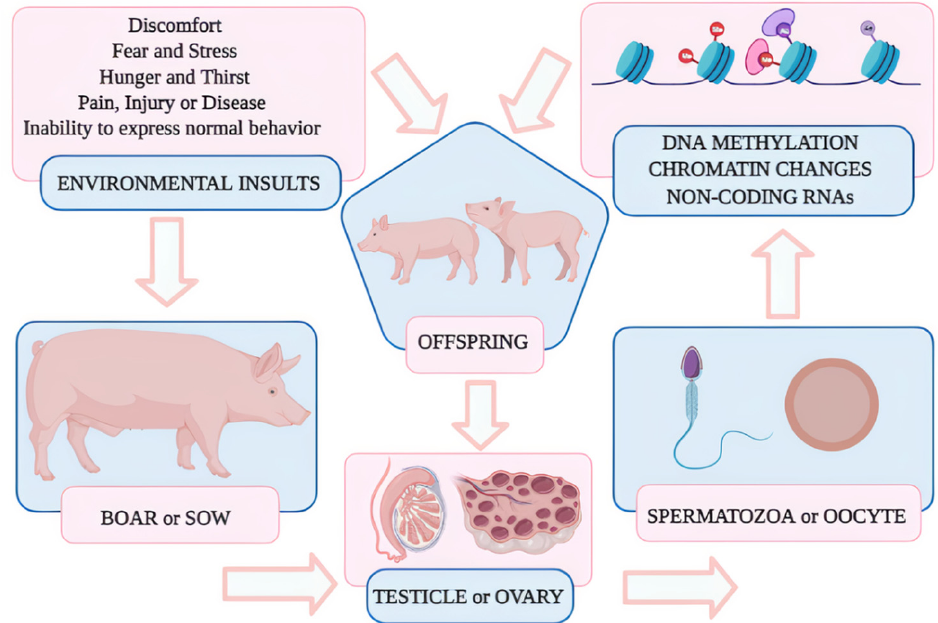
Figure 2. A possible pathway of epigenetic transmission in industrial pig production